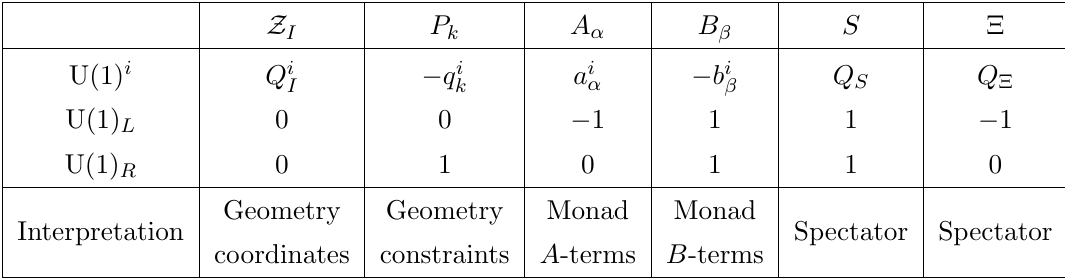
Table 1 . Overview of GLSM (cid:12)elds and their U(1)